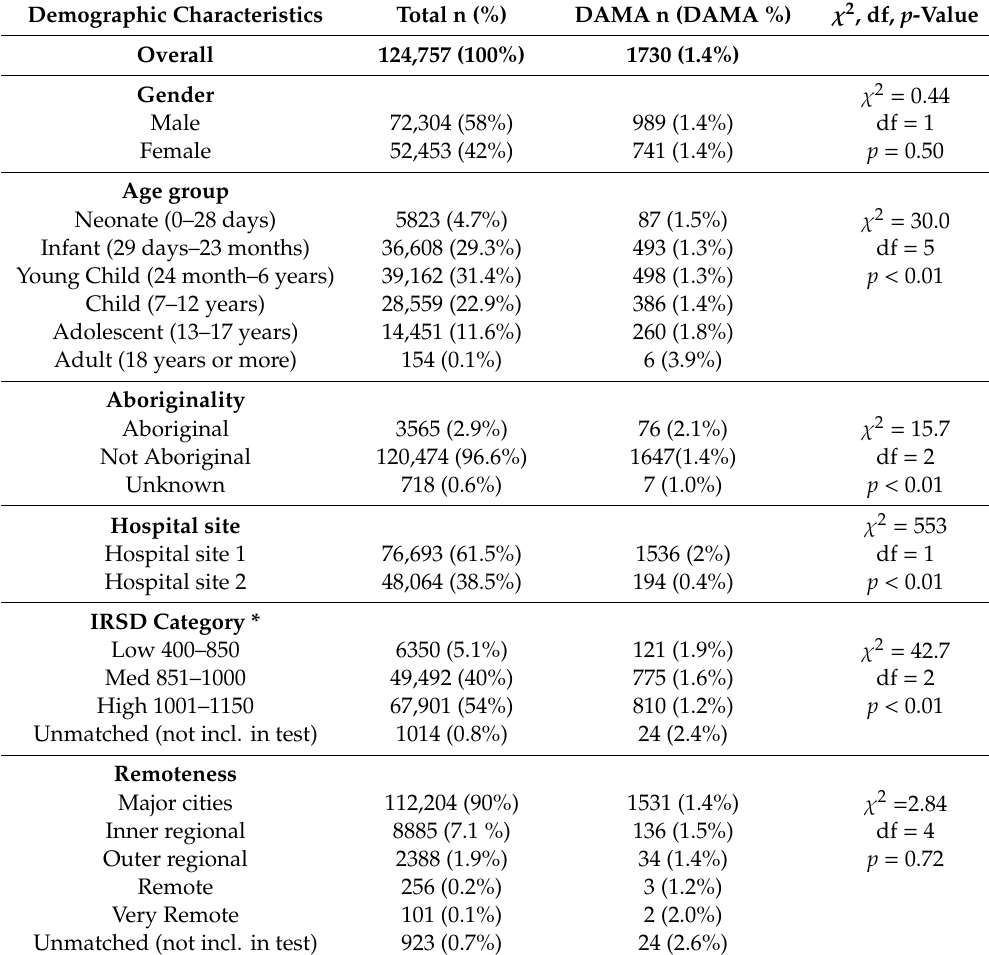
Table 1. Demographic characteristics (by number of